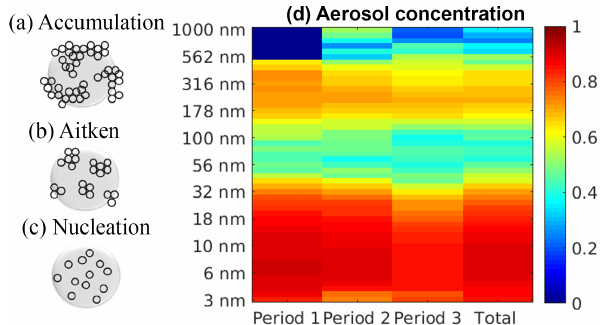
Figure 7. The correlation levels are obtained through the MI method for the particle number size distribution at the SMEAR II station in Hyytiälä. The colour shows the level of correlation. The first three columns represent three periods between years 1996 and 2014, where each period consists of the correlation level for 6 years. The last column indicates the total correlation level for 18 years. Note that the dark blue on period 1 for particles larger than 500nm is due to unavailable data for that size